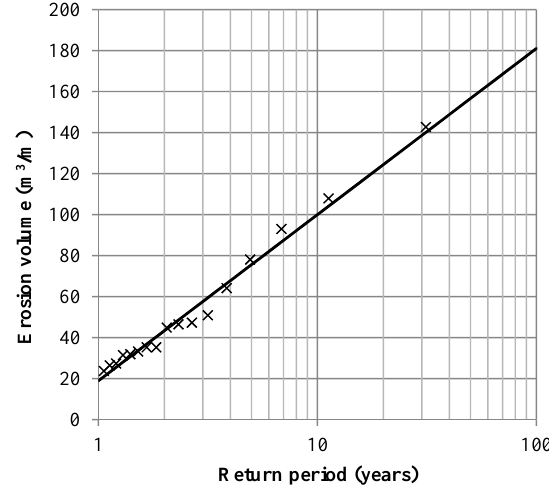
Fig. 4. The return periods of XBEACH simulated erosion volumes for profile C with the fitted exponential distribution (solid